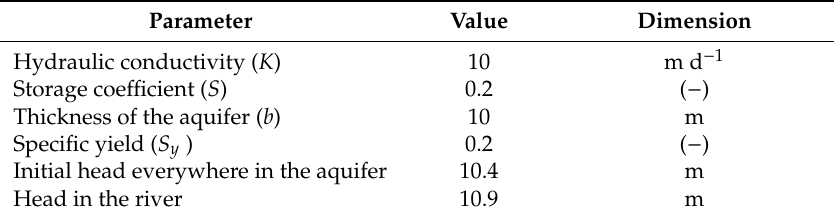
Table 1. Parameters and dimensions of the unconfined and confined aquifer.